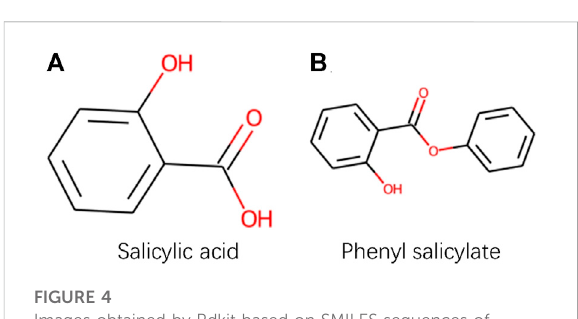
FIGURE 4 Images obtained by Rdkit based on SMILES sequences of Salicylic acid and Phenyl